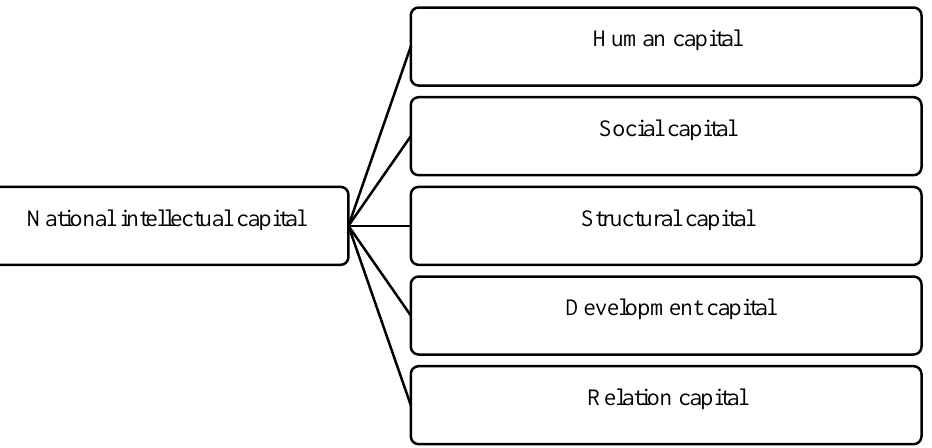
Fig. 1. Structure of national intellectual capital developed by the authors